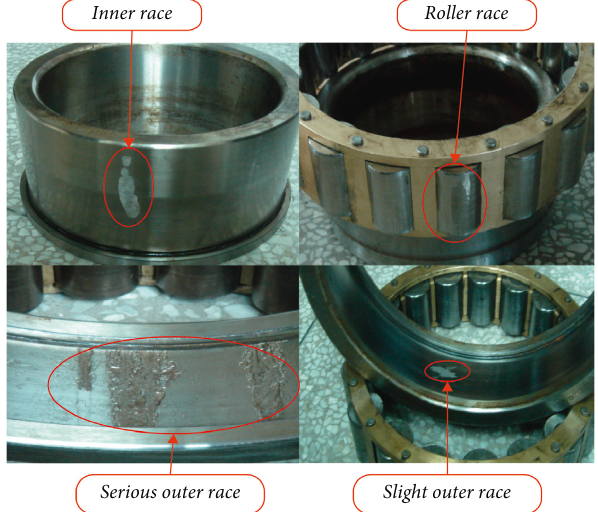
Figure 7: Four types of rolling bearing